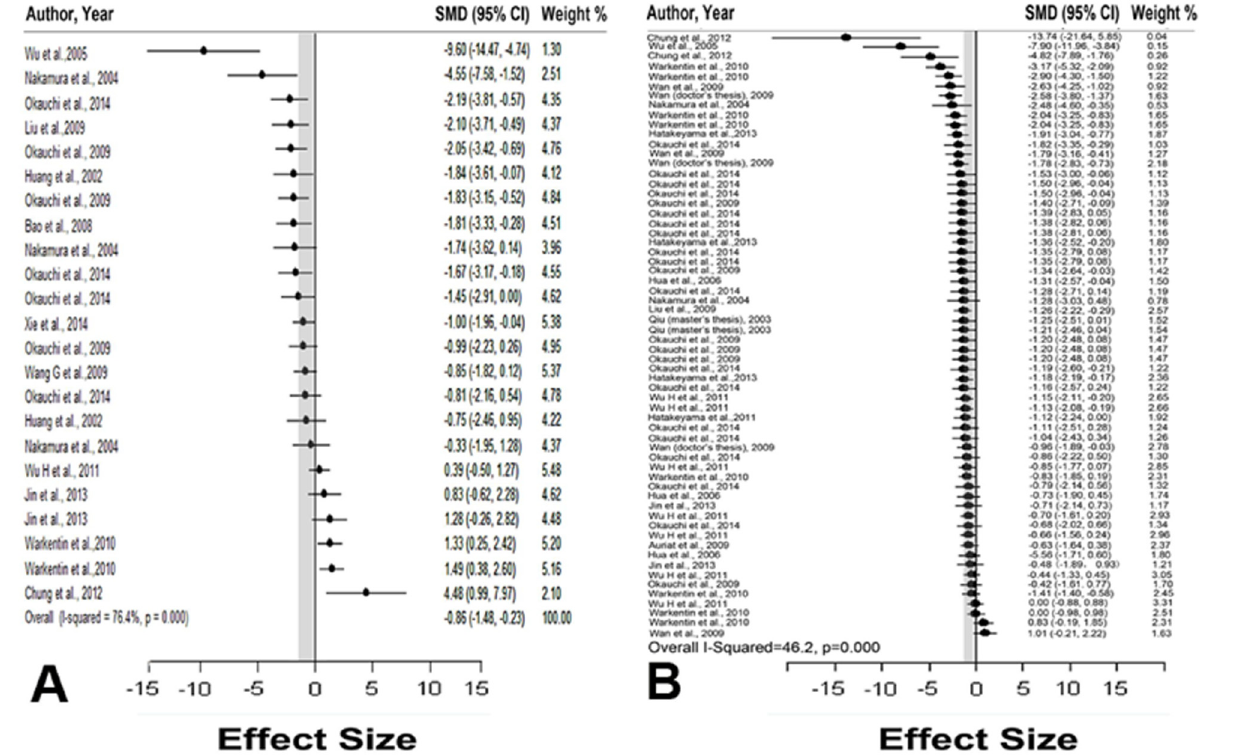
Fig 2. Effect sizes of included comparisons. A forest plot of the effect sizes for each comparison measuring (A) brain water content and (B) neurobehavioral outcomes. Gray bars represent 95% confidence